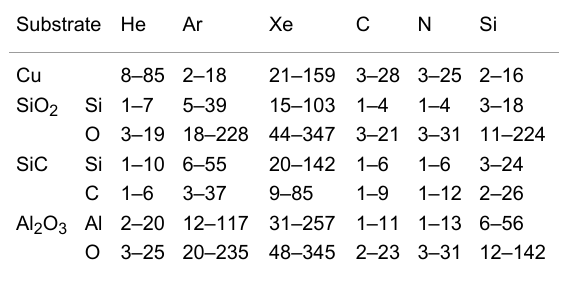
Table 1: Incident ion energy ranges (in keV) which correspond to the most effective sputtered substrate atom implantation into various 2D materials, i.e., sputtered atoms have energy in the 25–75 eV/atom range. Substrate